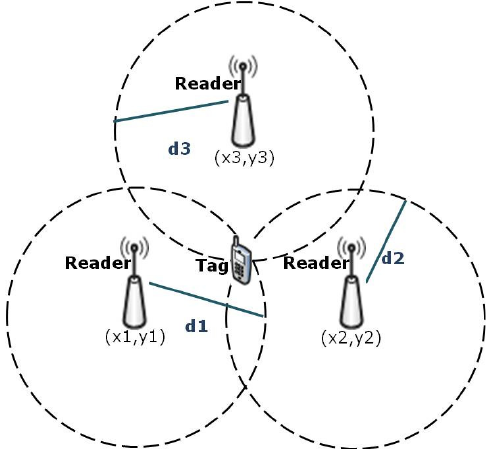
Fig. 2. Multi-lateration (TOA)